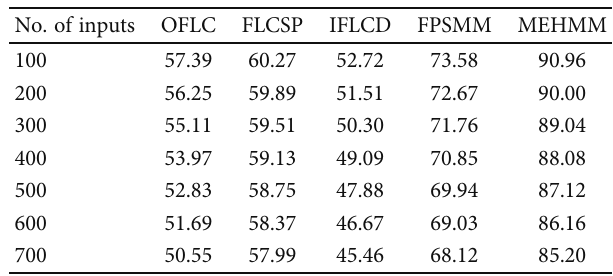
Table 7: Sensitivity to